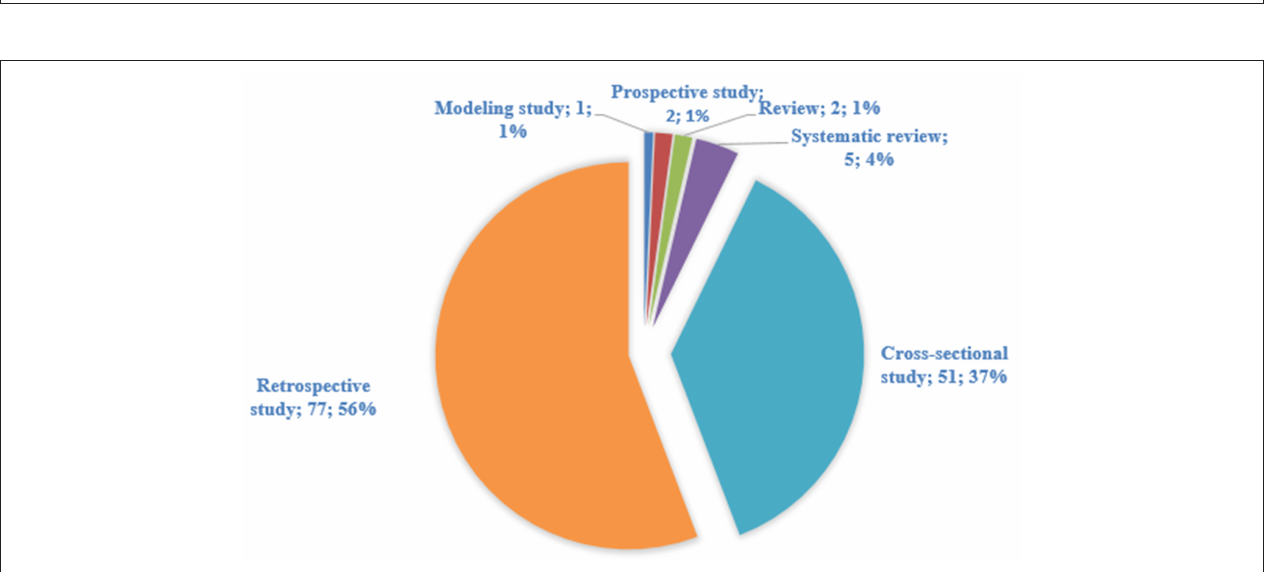
FIGURE 2 | Pie chart showing study designs for studies on breast, cervical and prostate cancer in Sub-Saharan Africa.